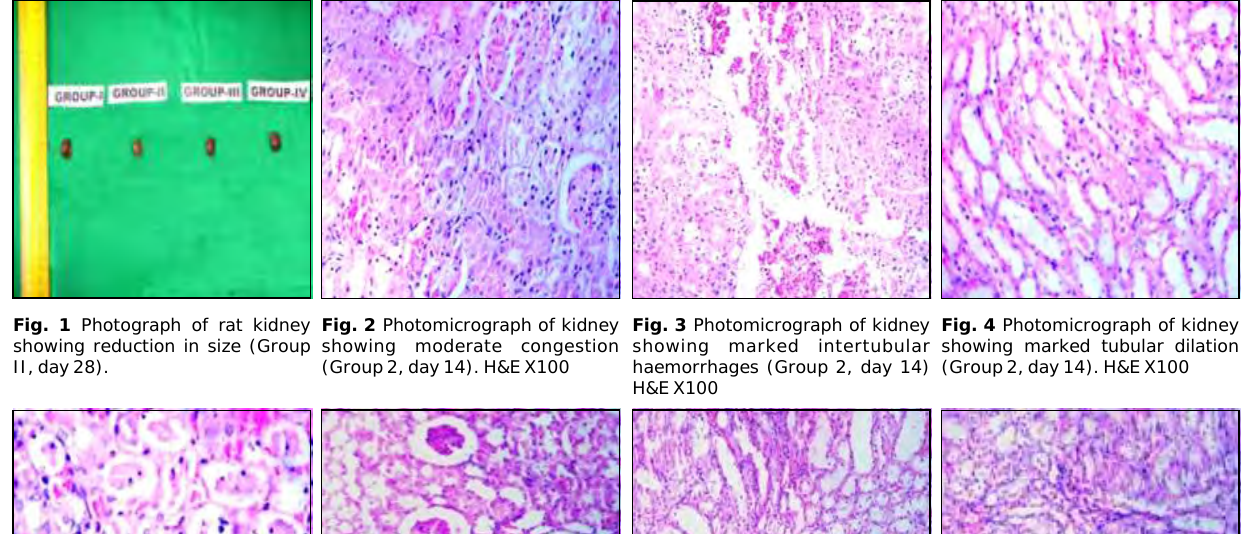
Fig. 7. Photomicrograph of Kidney showing moderate tubular dilation and mild degenerative changes (Group 4, day 14). H&E X 100